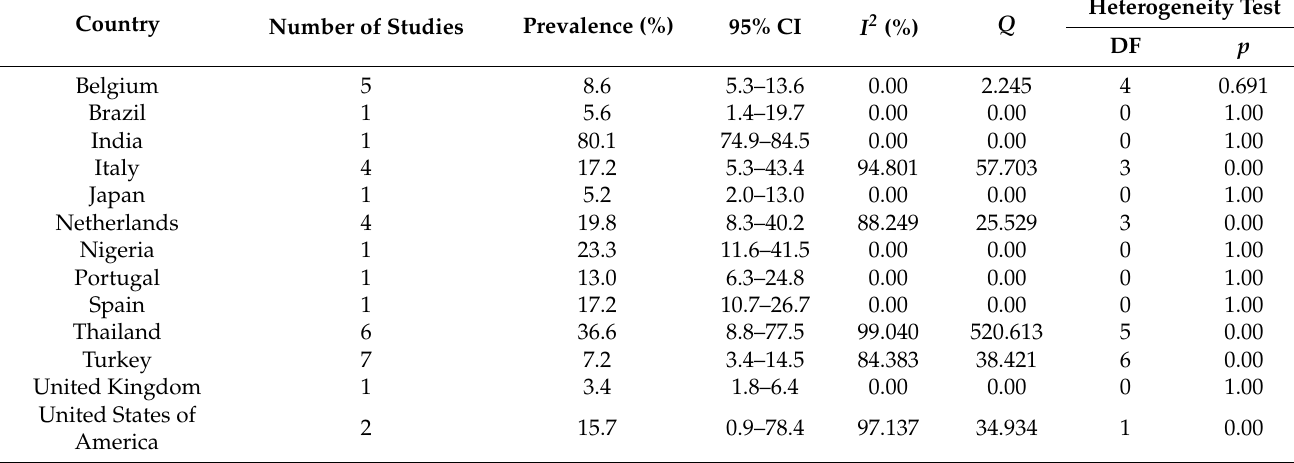
Table 4. Subgroup analysis for comparison of prevalence of VRE in companion animals according to country.